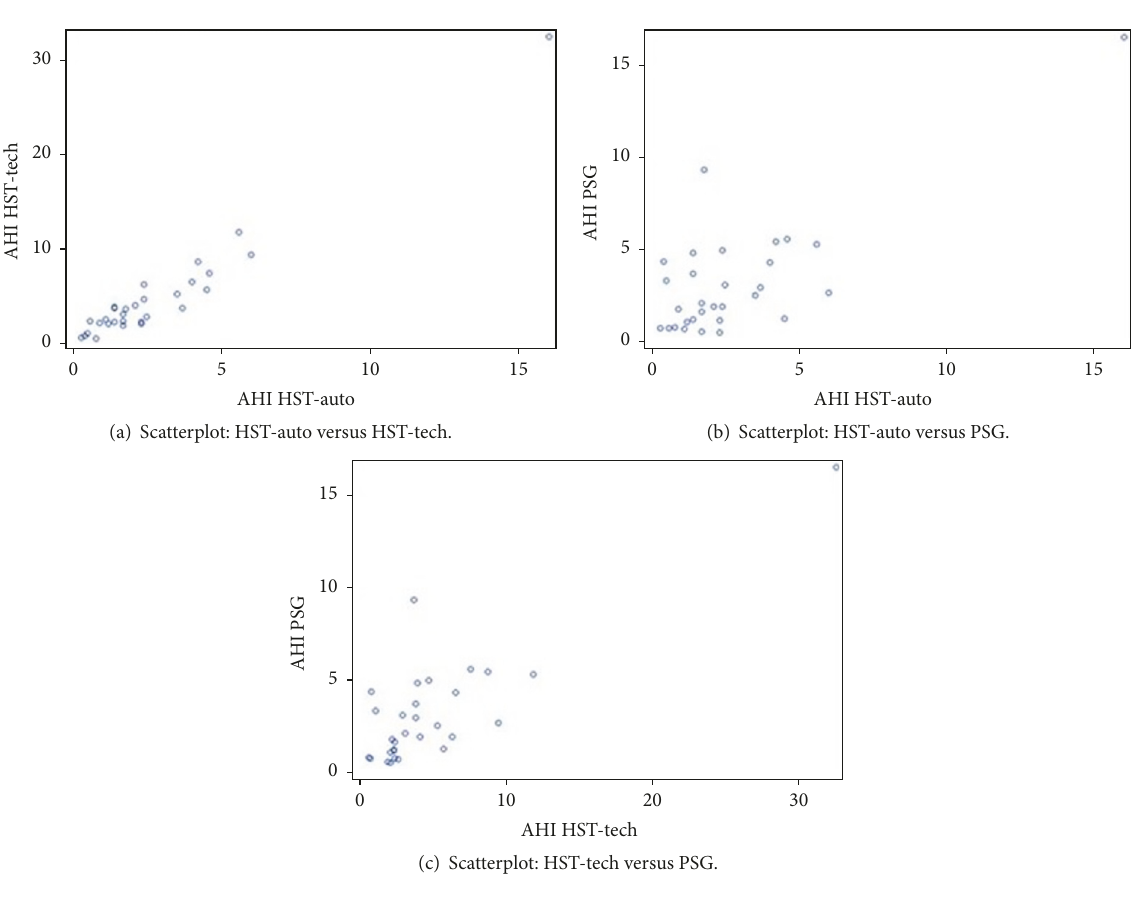
Figure 1: (a)–(c) Scatterplots of AHI comparisons. (a) HST-auto vs. HST-tech, (b) HST-auto vs. PSG, and (c) HST-tech vs. PSG.